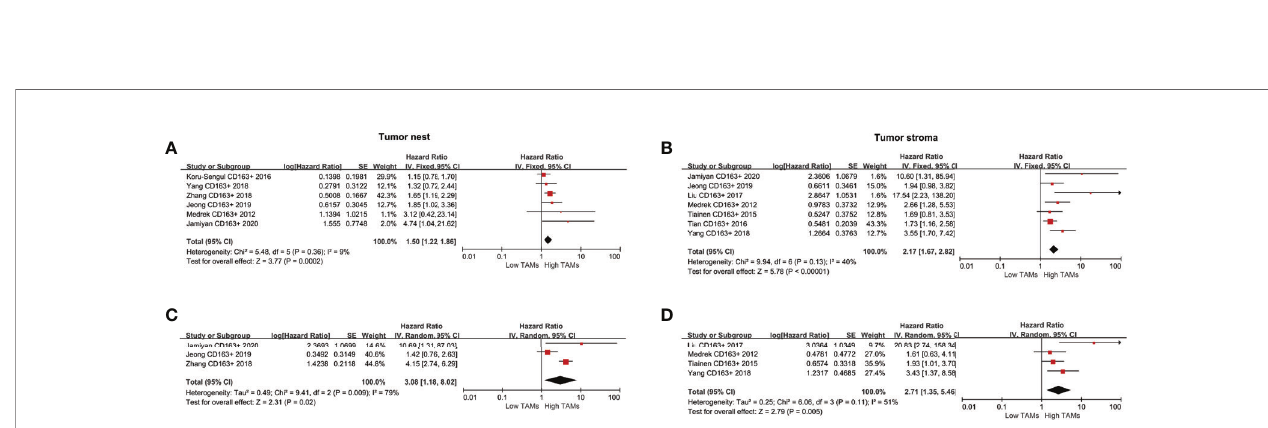
FIGURE 3 | Forest plots of HRs for DFS between high and low CD68+ TAM density in BCa patients. (A) HRs of DFS in raw data for CD68+ TAMs in the TN of BCa; (B) HRs of DFS in raw data for CD68+ TAMs in the TS of BCa; (C) HRs of DFS with adjusted measures for CD68+ TAMs in the TN of BCa; (D) HRs of DFS with adjusted measures for CD68+ TAMs in the TS of BCa.